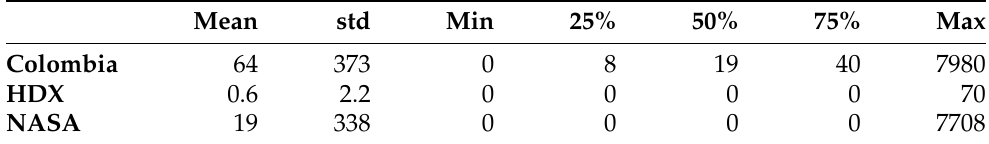
Figure 2. Number of Downloads distributions for the geospatial datasets of the Colombia, HDX, and NASA portals (up to December 2019). Table 3. Descriptive Usage Statistics: number of Downloads (up to December